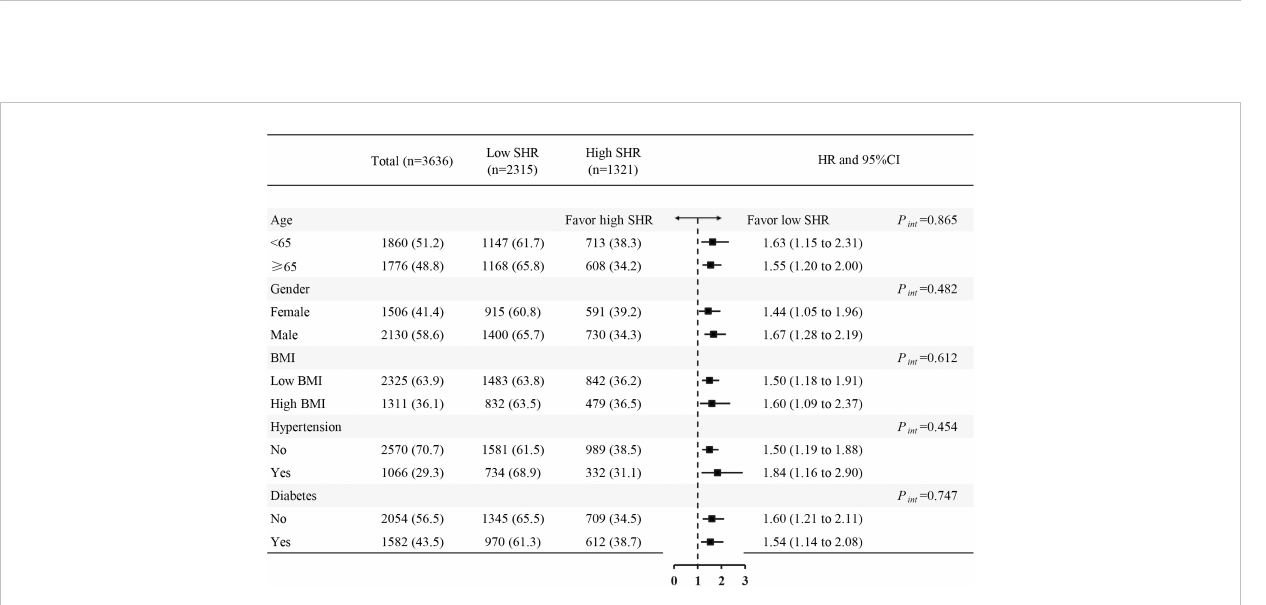
FIGURE 3 Forest plots of hazard ratios for the 1-year all-cause mortality in different subgroups. HR, hazard ratio; CI, con fi dence interval; SHR, stress hyperglycemia ratio; BMI, body mass index.